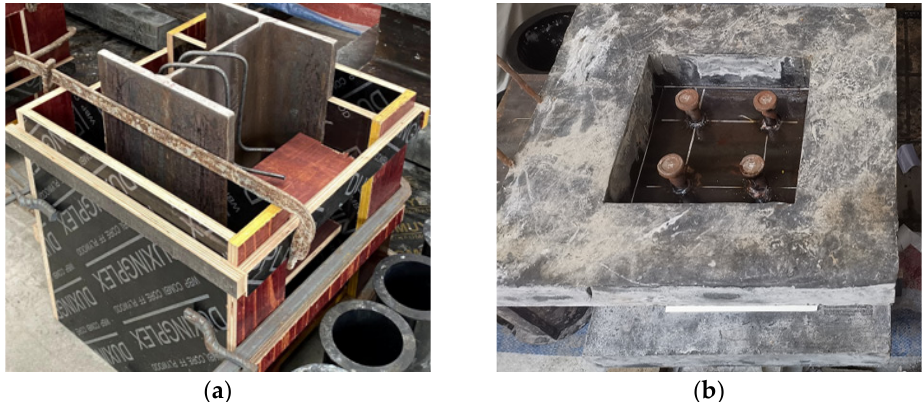
Figure 2. Fabrication procedure of test specimens: ( a ) for monolithic casting specimen; ( b ) for precast slab specimen.